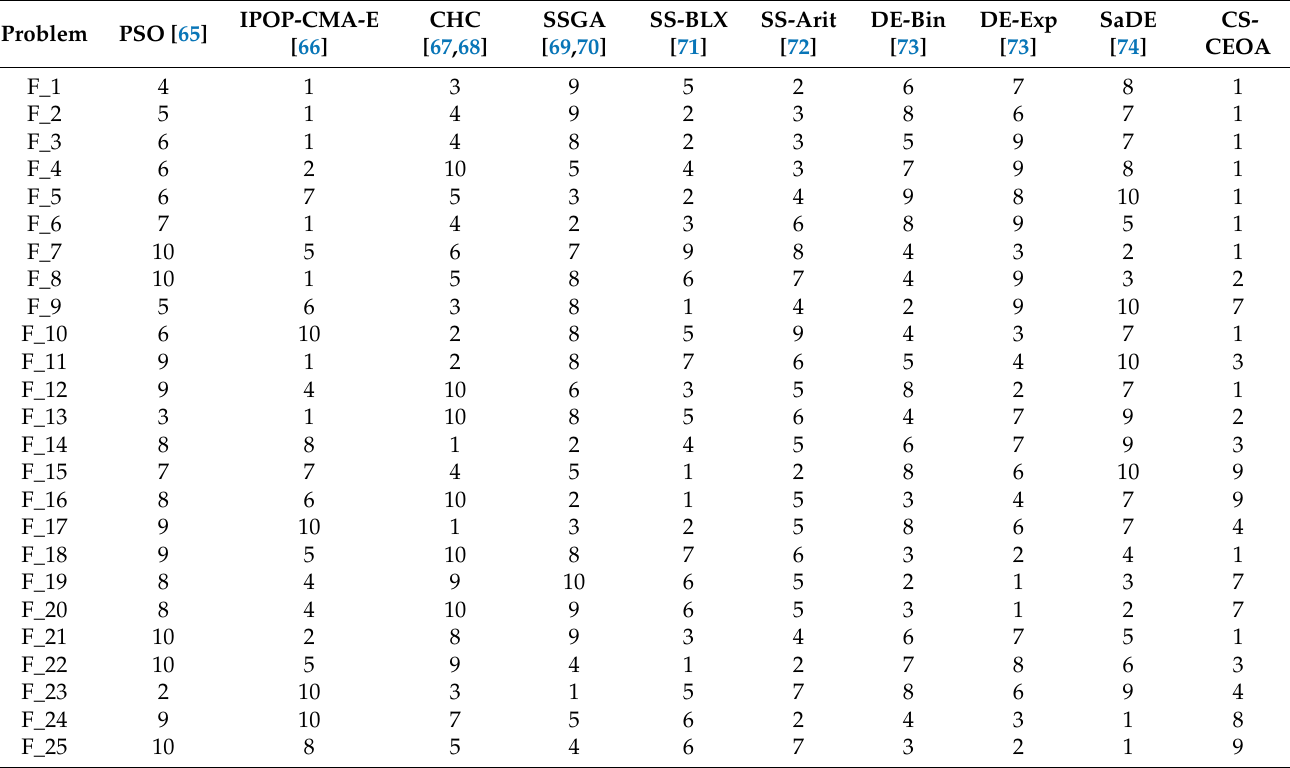
Table 6. Average error ranking of the 25 CEC’05 problems for all algorithms.